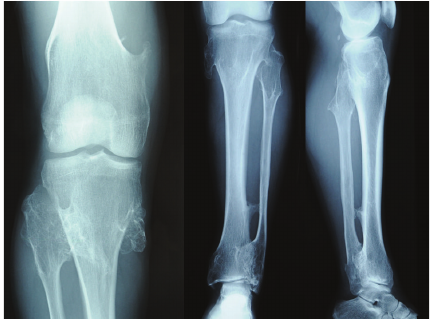
Figure 2: Radiographs of the right knee joint showing osseous projection.